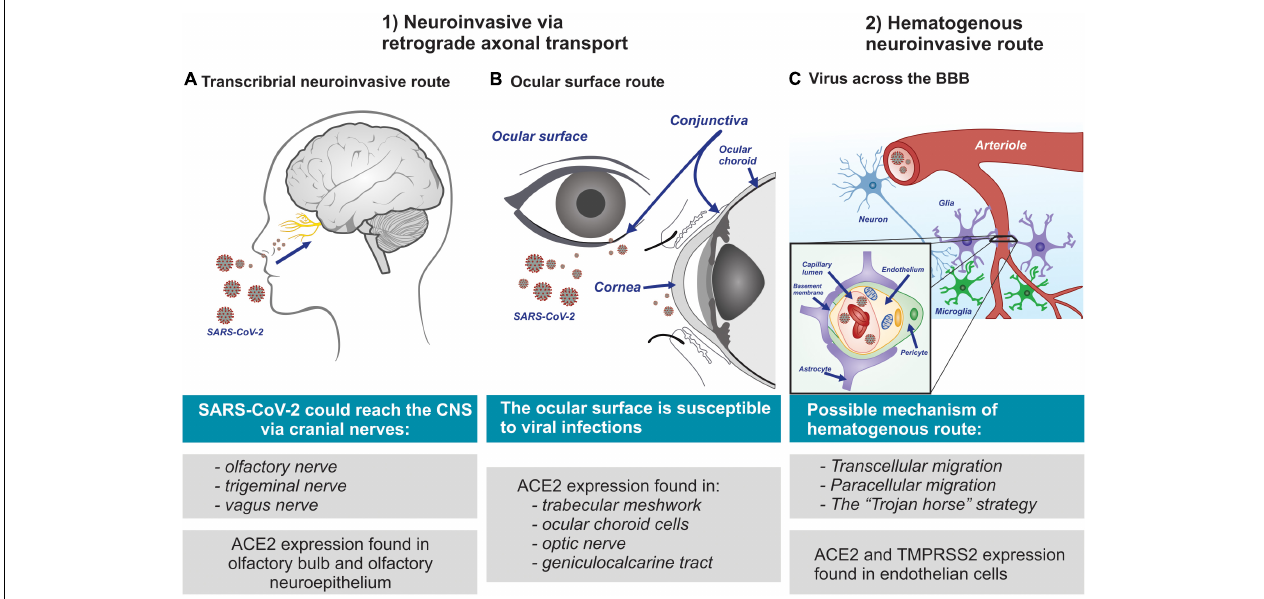
FIGURE 2 | Mechanisms suggested through which SARS-CoV-2 invades the nervous system. (A) Transcribrial neuroinvasive route; SARS-CoV-2 may invade the brain through the olfactory nerve, and via cranial nerves. (B) Route ocular surface; multiple cell types of the visual system are suggested provide as potential entry points for SARS-CoV-2 invasion to the brain. (C) Hematogenous neuroinvasive route; SARS-CoV-2 possibly infects vascular endothelial cells via the ACE2 and TMPRSS2 receptors. Viral particles can reach the brain through the BBB by infecting and replicating inside brain microvascular endothelial cells. Moreover, SARS-CoV-2 infection can cause excessive peripheral immune responses to result in BBB dysfunction via cytokine